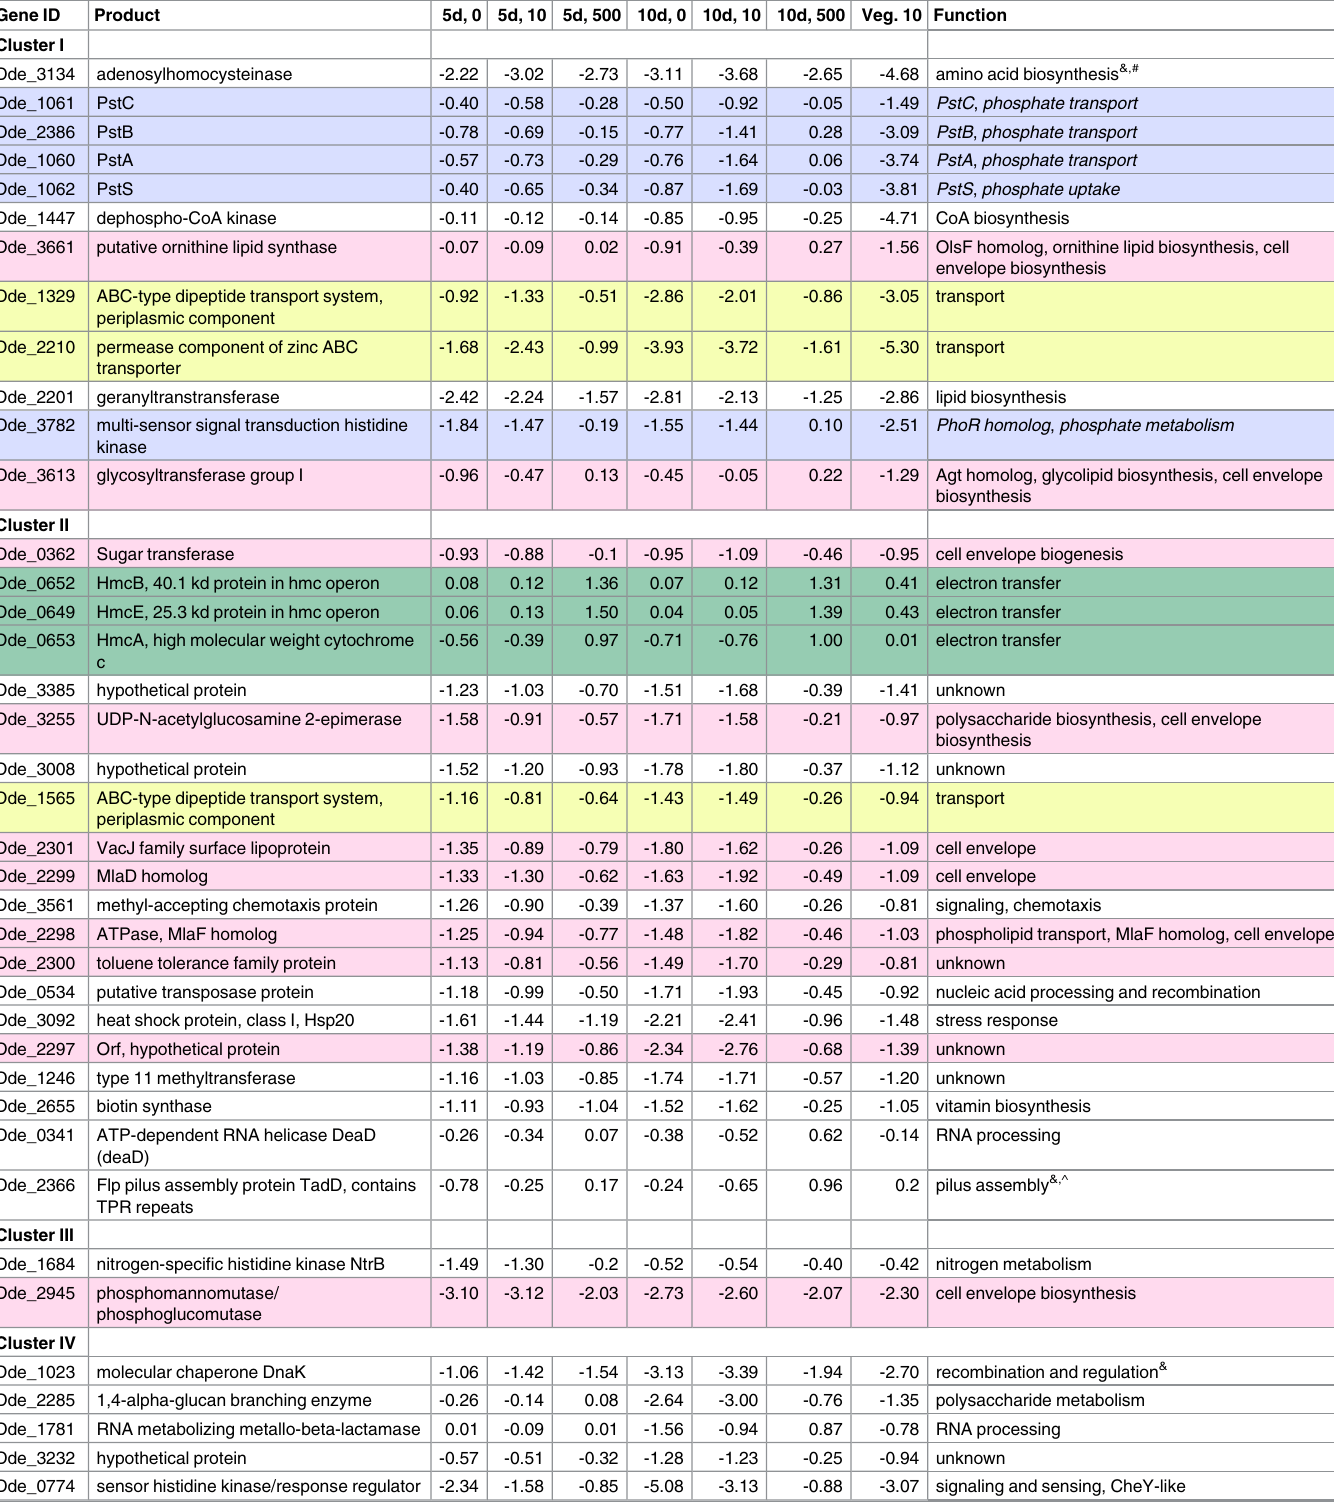
Table 1. Fitness scores of genes important during phosphate-limited growth and for the survival after phosphate starvation. Gene